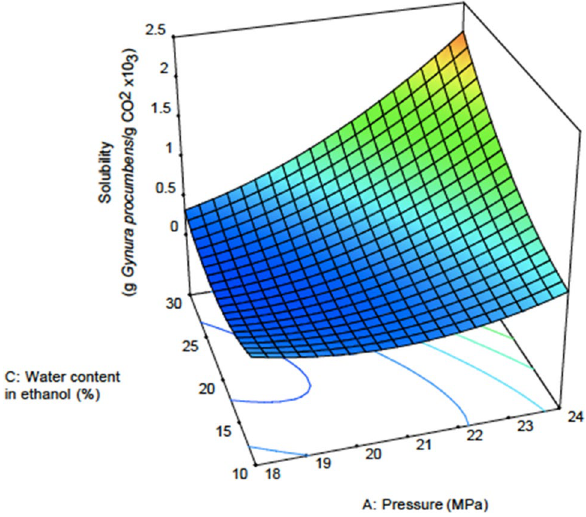
Figure 4. Response surface plot for solubility versus pressure and water content in ethanol.